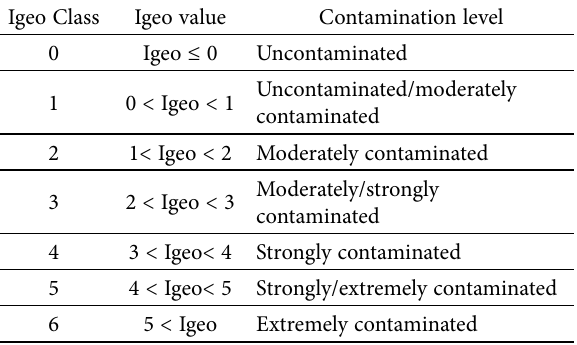
Table 1. The Geoaccumulation Index (Igeo) for assessing contamination levels in soil (Rahman et al. 2012)